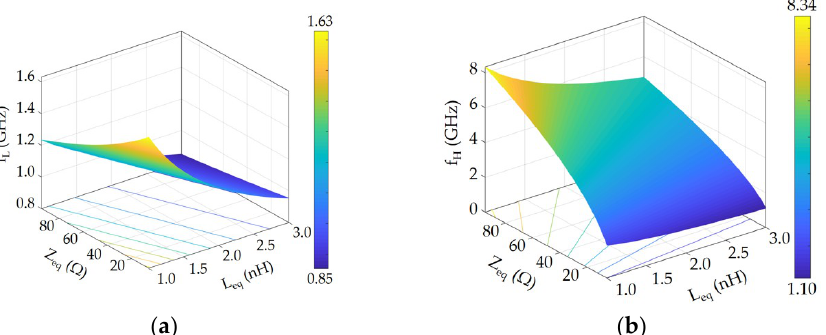
Figure 4. Variations of ( a ) f L and ( b ) f H for various Z eq and L eq values obtained using the closed-form expressions.